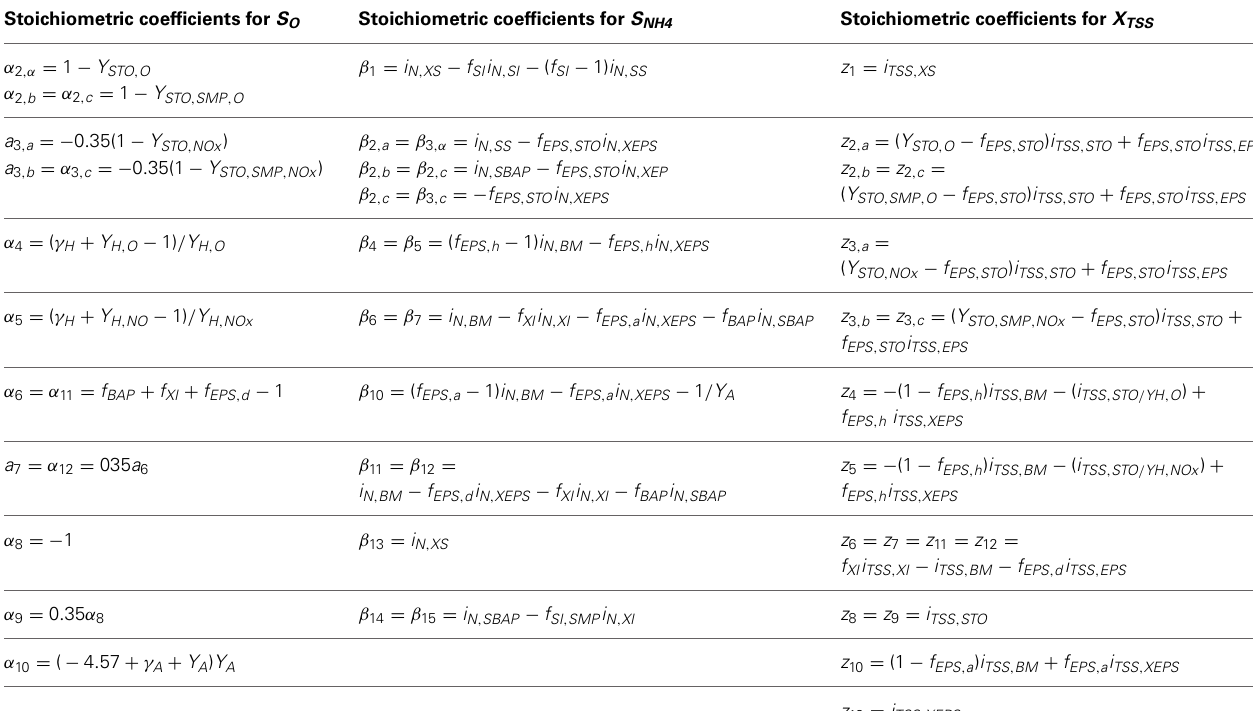
Table 4 | Stoichiometric coefficients for S O , S NH 4 and X TSS which are presented in Table 3.